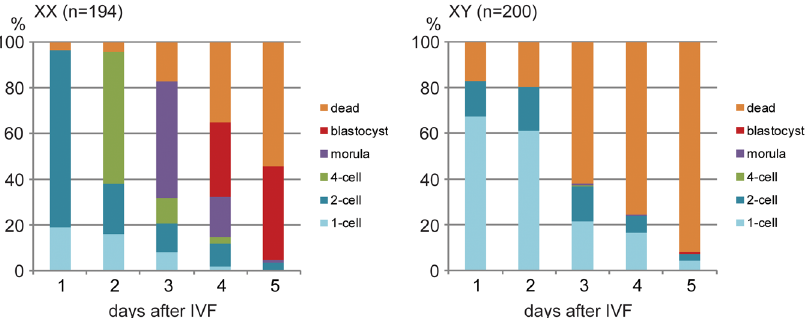
Figure 2. Failure in the embryonic development from the oocytes ovulated by XY females. Each column indicates the percentages of embryos at different stages at 1–5 days after IVF. “Dead” includes dead or fragmented embryos. The total number of oocytes examined is given in parentheses at the top of each